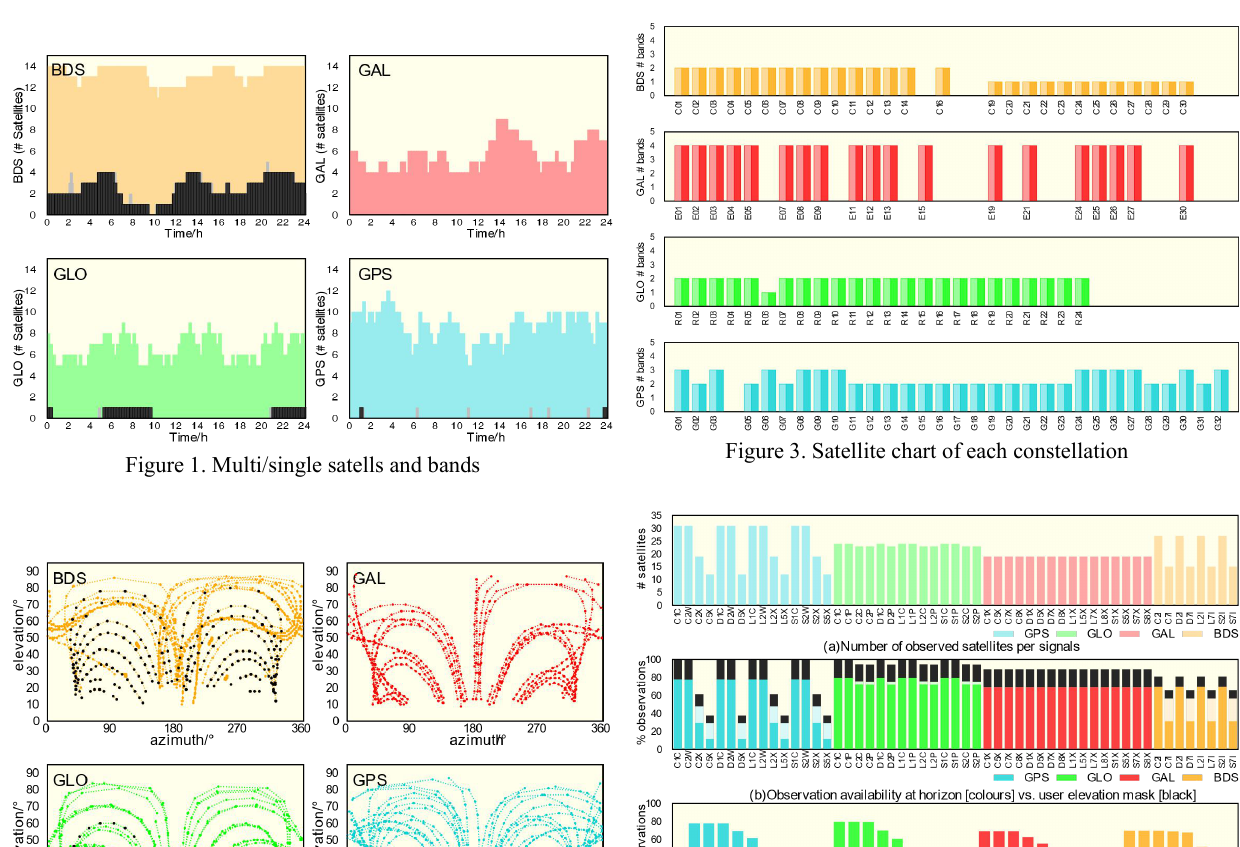
Figure 4. Statistics of the number of observation